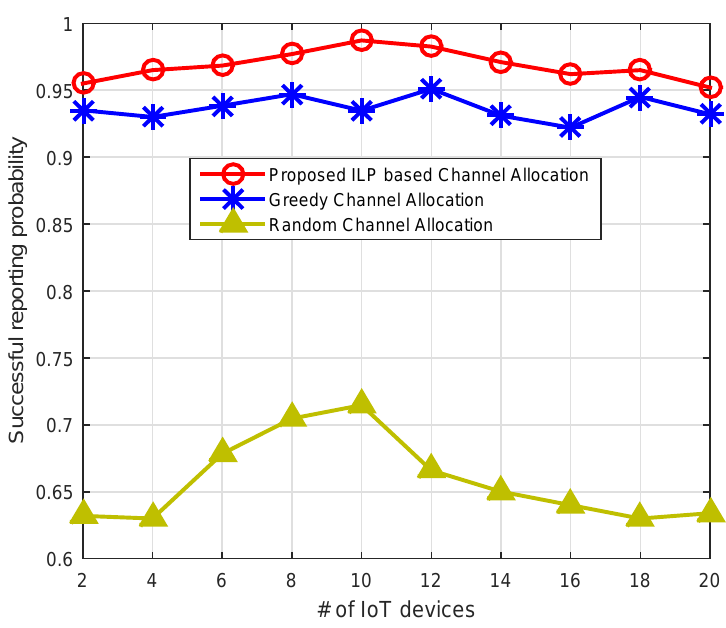
Figure 10. Comparison based on successful reporting probability across number of IoT devices.